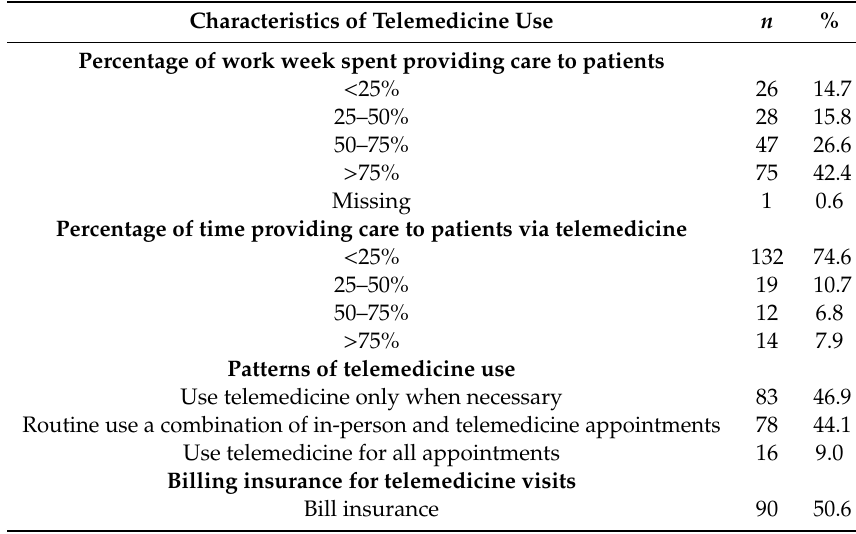
Table 2. Telemedicine use among mental health providers, N = 177.